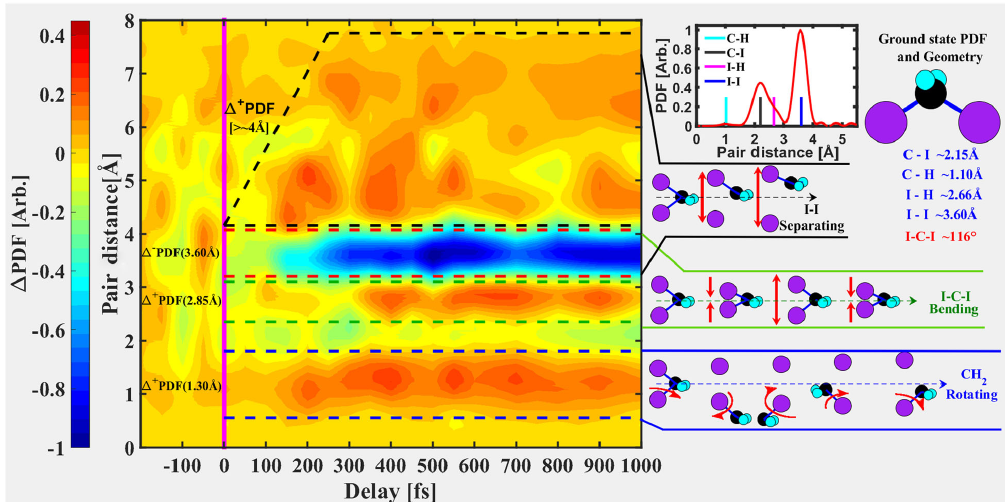
FIG. 3. Measured Δ PDF as a function of pump-probe delay. A vertical magenta-colored line marks zero pump-probe delay. The data are normalized by the largest value of Δ PDF. Four regions corresponding to specific molecular motions are highlighted with dashed lines in different colors. Snapshots on the right side of the graph illustrate the different types of motion highlighted in the regions bounded by the dashed lines to the left. A cartoon picture on the top right of the graph shows the ground-state equilibrium geometry of CH 2 I 2 , with black, purple, and cyan colored balls representing the carbon, iodine, and hydrogen atoms, respectively. The atomic pair distances (blue) and I-C-I angle (red) are labeled underneath. The corresponding ground-state PDF and atomic pair distances are plotted